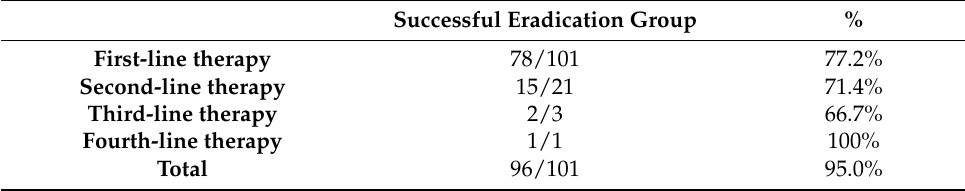
Table 1. The successful eradication rate of Helicobacter pylori after different lines of